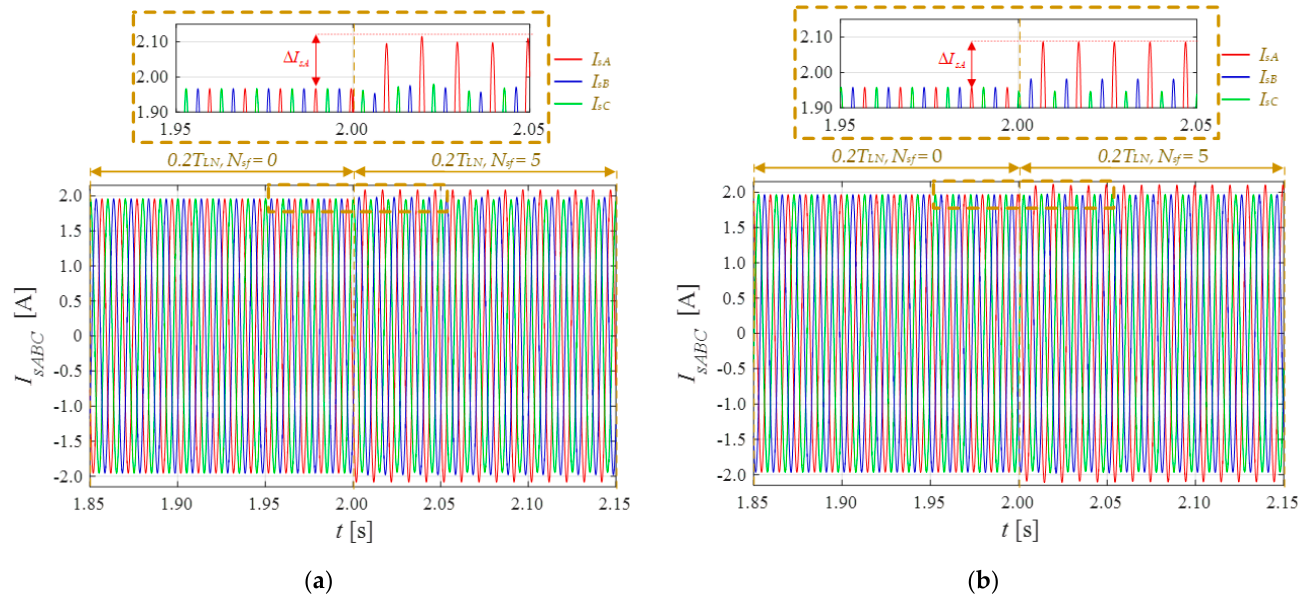
Figure 8. Phase current waveforms at the moment of short-circuit N sf =5 turns in the PMSM motor for f s = 100 Hz, T L = 0.2 T N : scalar control (open system with load torque compensation) ( a ), field-oriented control ( b ).